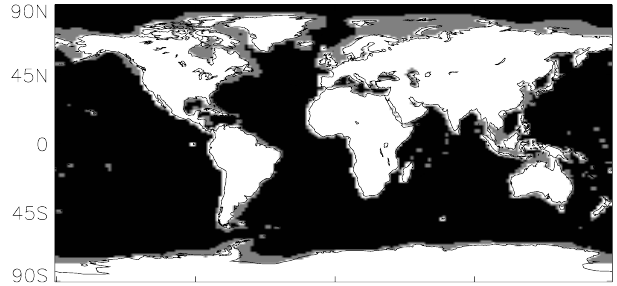
Fig. 16. Land sea masks used by HadGEM2-ES. Modern and mid- Holocene land points are denoted by white and additional LGM land points by grey. Black points denote points that are ocean in all